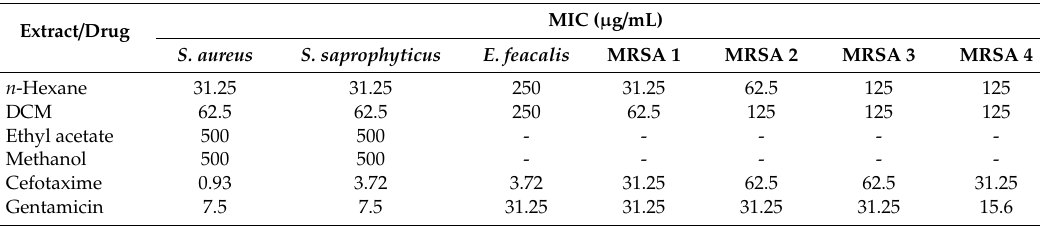
Table 3. MIC values of the di ff erent extracts prepared from G. cambogia against S. aureus , S. saprophyticus , E. feacalis and MRSA strains. Data are given as means, n = 3.